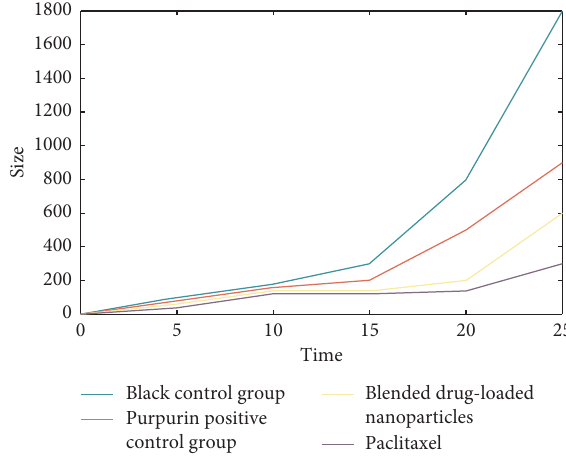
Figure 3: Line chart of lung tumor volume change. Table 1: IC50 values of lung tumor